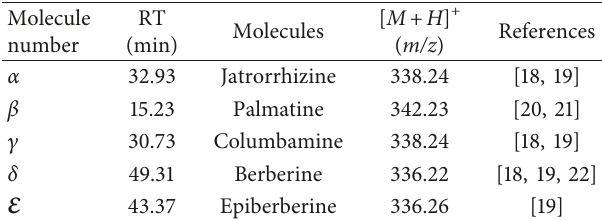
Table 1: Summary of the major components of Berberis vulgaris ethanol